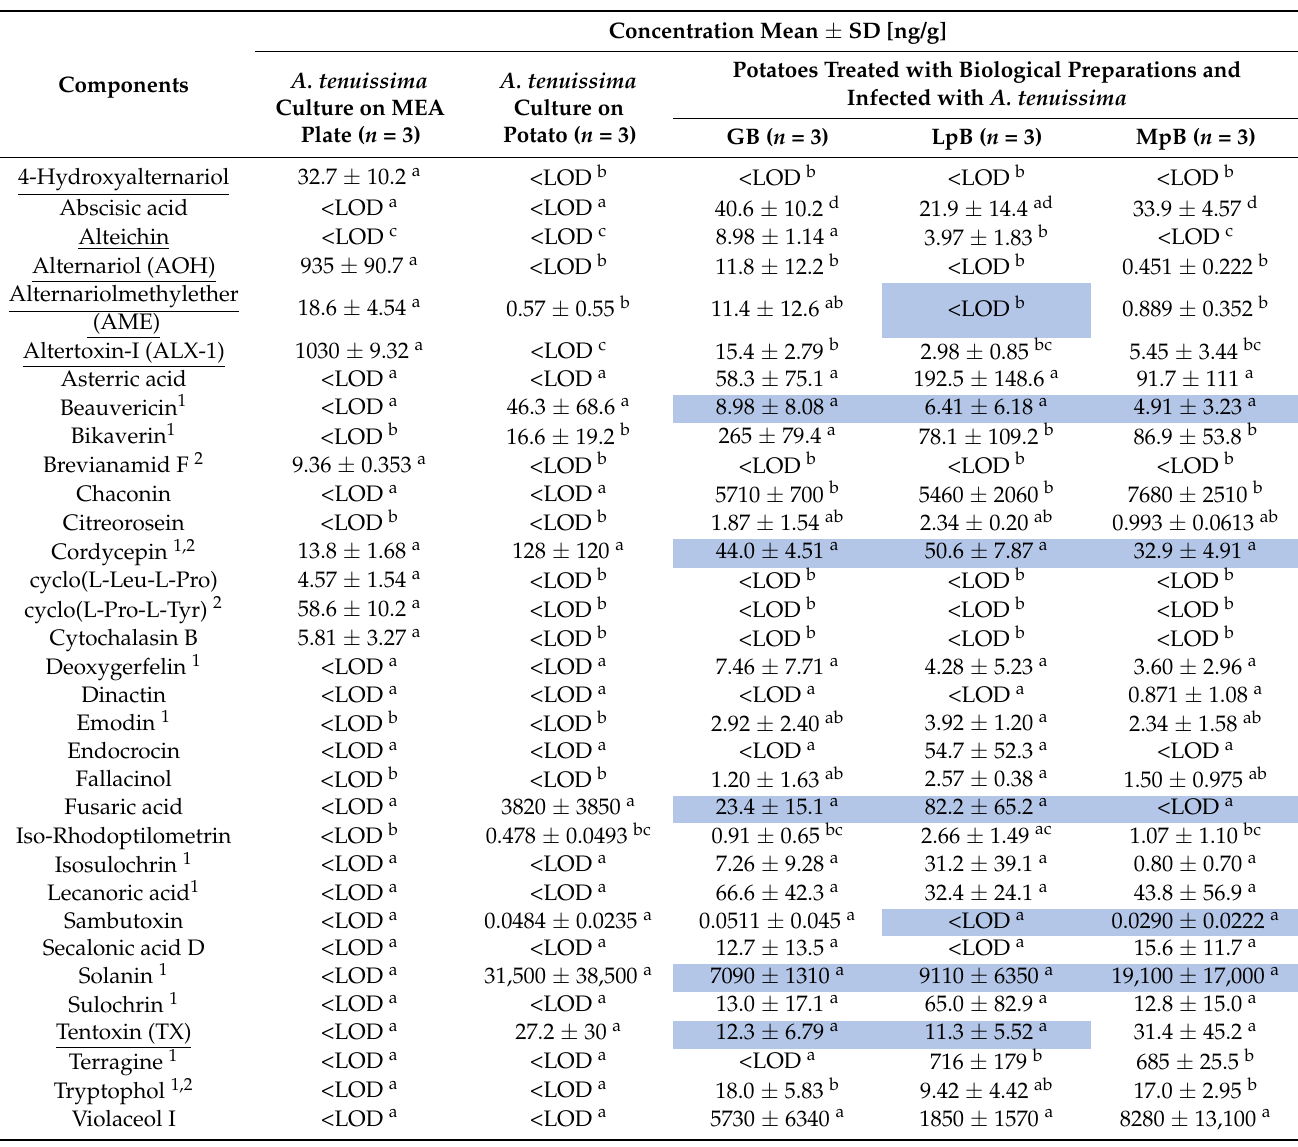
Table 2. Secondary metabolites of Alternaria tenuissima growing on MEA plates and potatoes treated with